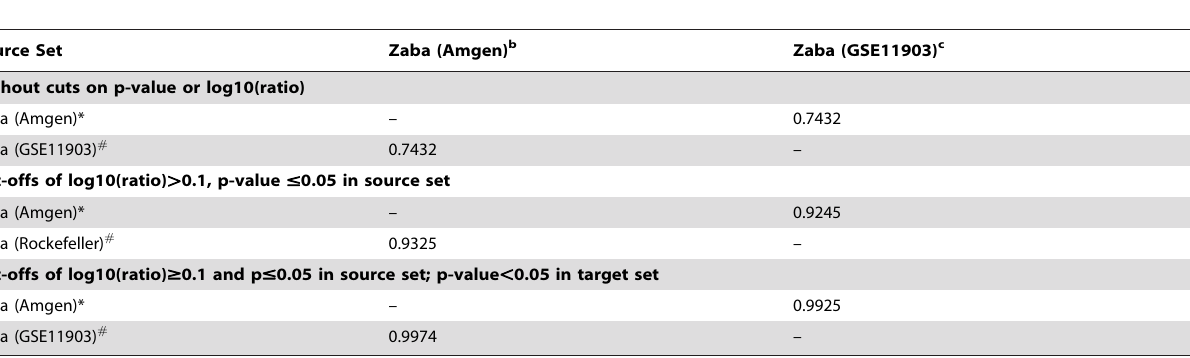
Table 5. Proportion of Probe Sets a Agreeing in the Direction of Expression Change (Log10(ratio)) between PN and PP Skin between Pre- and Post-Etanercept PP